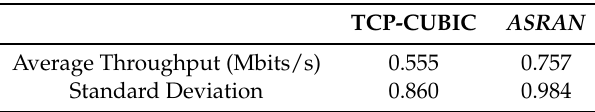
Table 2. Comparison of experiment in heavy traffic